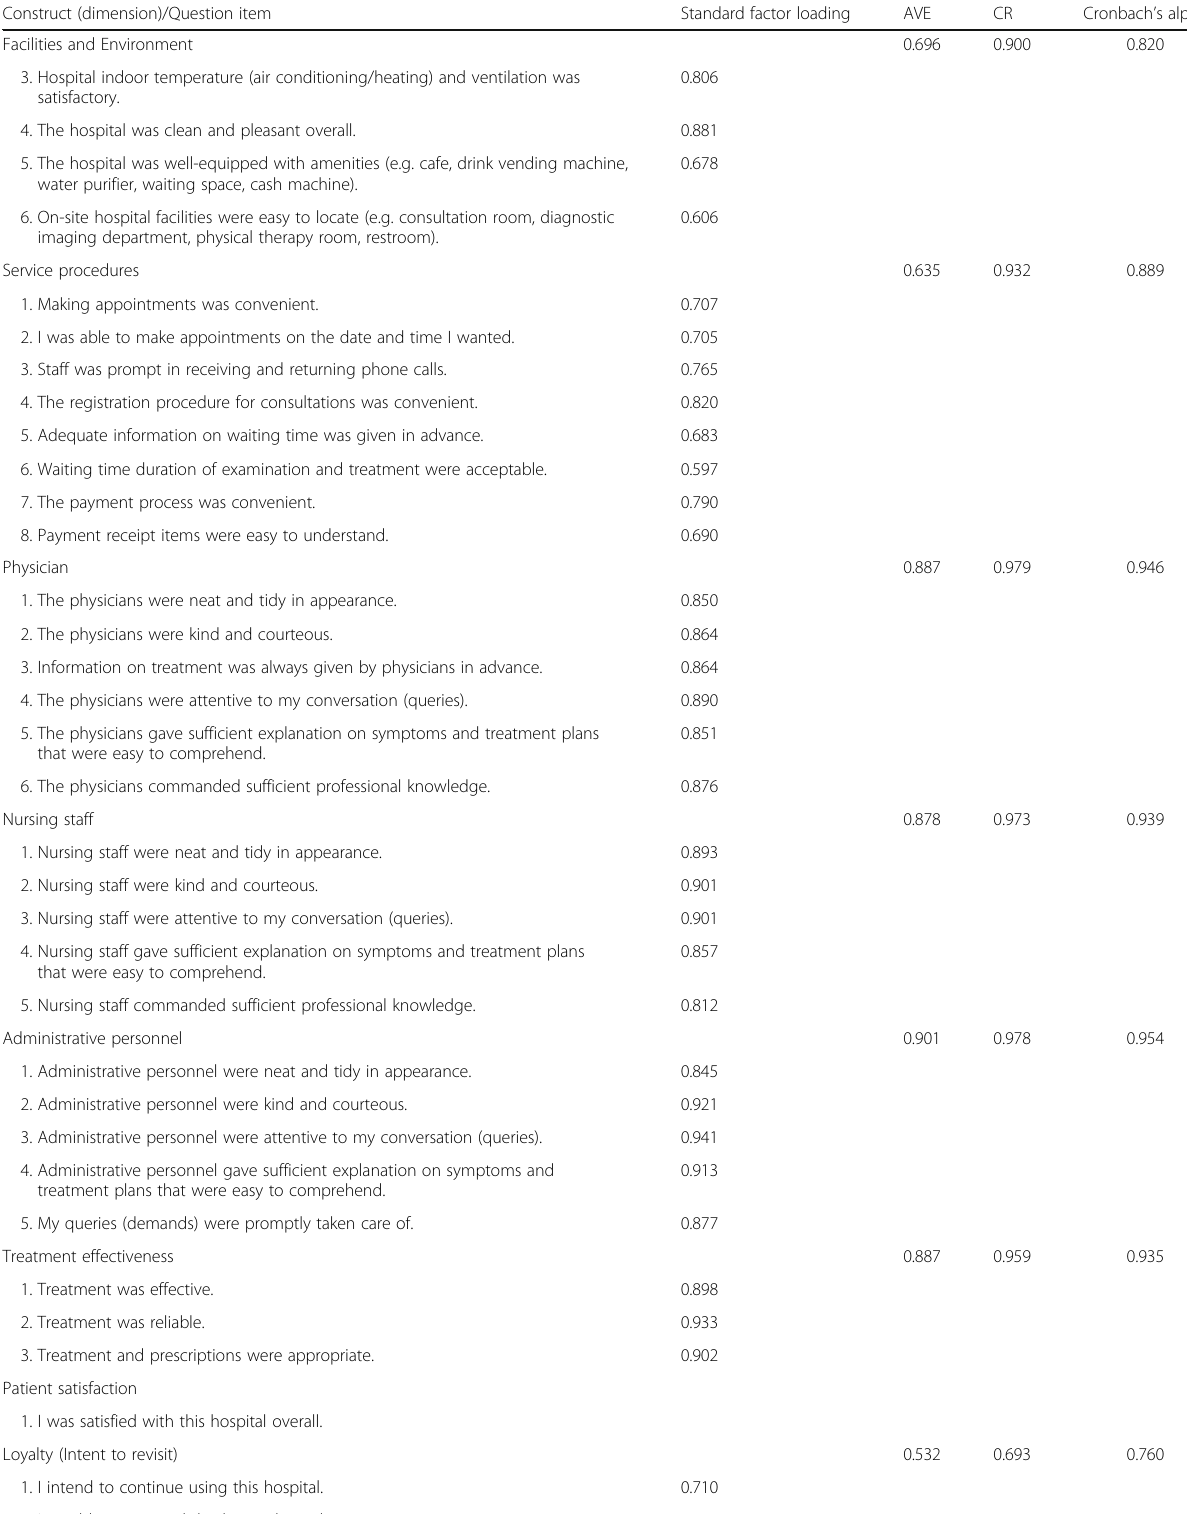
Table 2 Validity and reliability of questionnaire constructs and items Construct (dimension)/Question